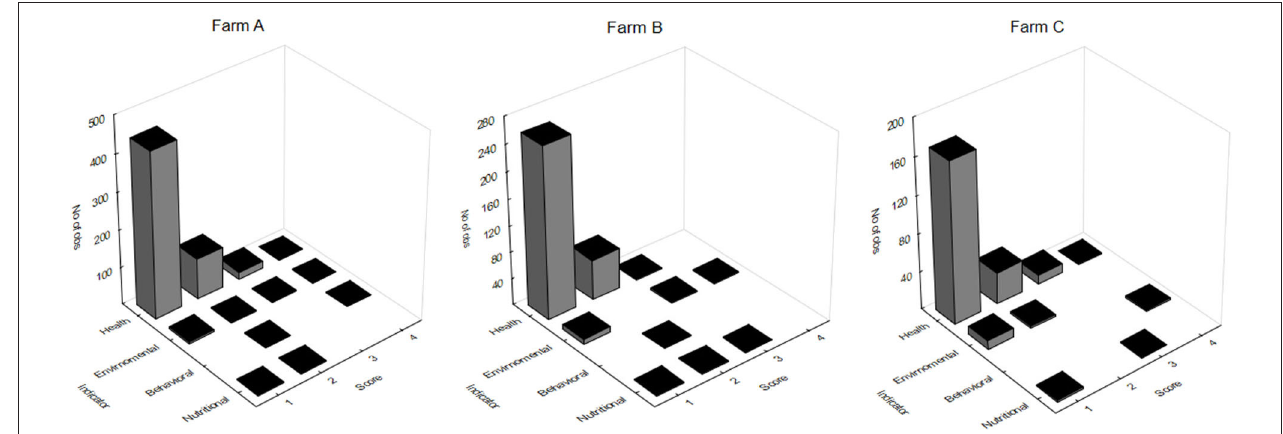
FIGURE 2 | Tilapia welfare scores obtained for health, environmental, nutritional, and behavioral indicators in three different farms (A-C) ; no significance was found when comparing farms (Kruskal-Wallis; p = 0.435).